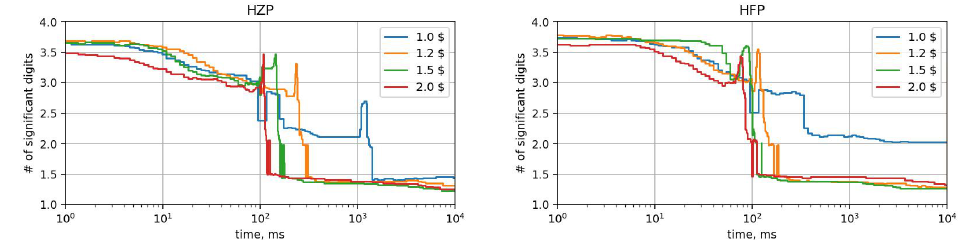
Figure 2. Number of significant digits estimated by CADNA for 9 × 9 matrix A and vector b and the initial structure of the input matrix; empty cells indicate zero elements.